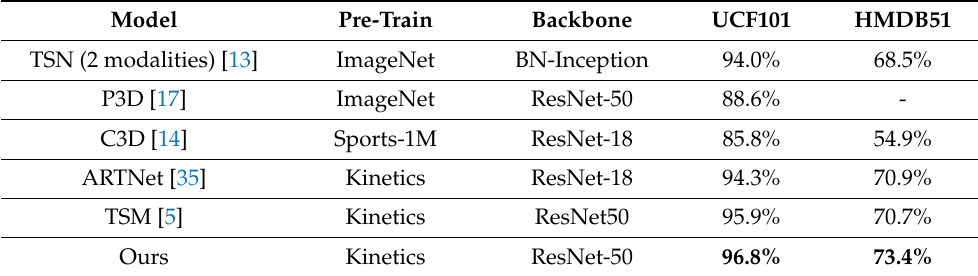
Table 6. Comparison of performances on UCF101 and